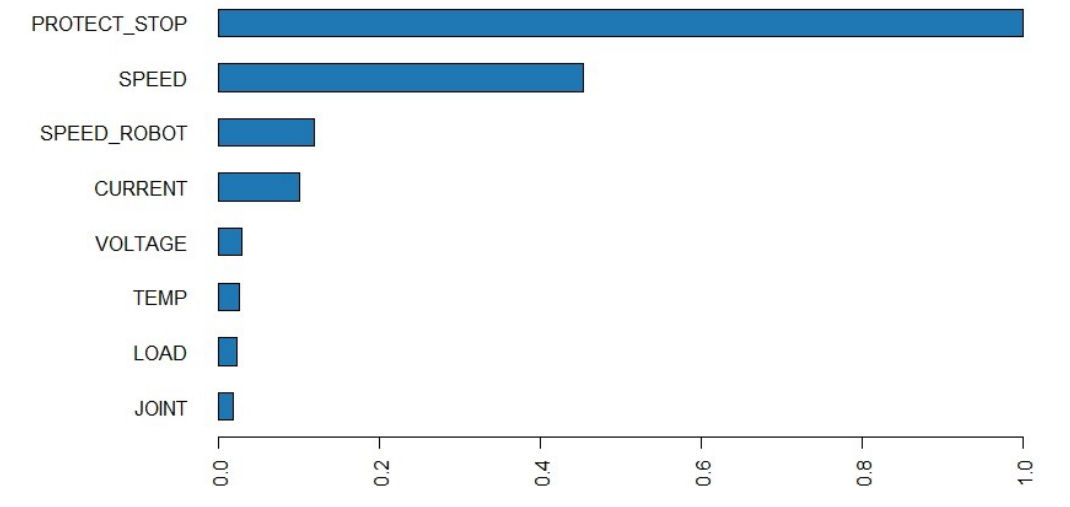
Figure 15. Importance of the variables on the different